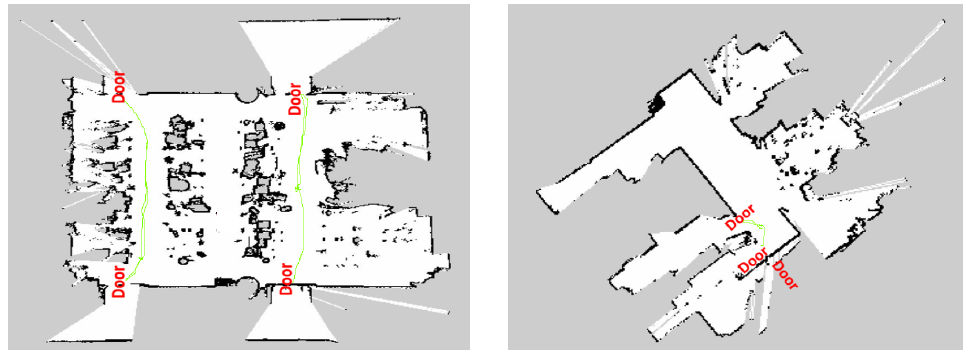
Figure 7. Localization result for test bed1 and test bed2.